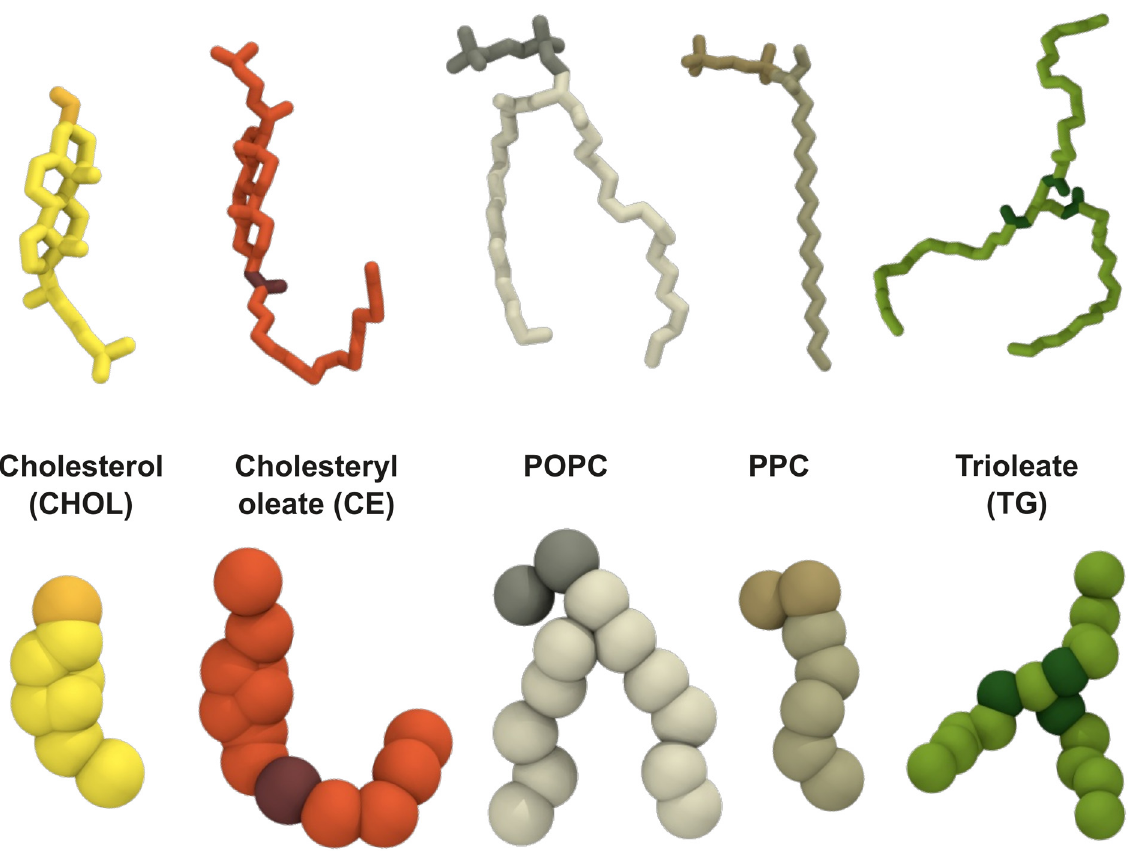
Figure 1. Descriptions of the molecules considered in the study. (Top) Atomistic (united atom) descriptions, and (bottom) the coarse-grained representations.